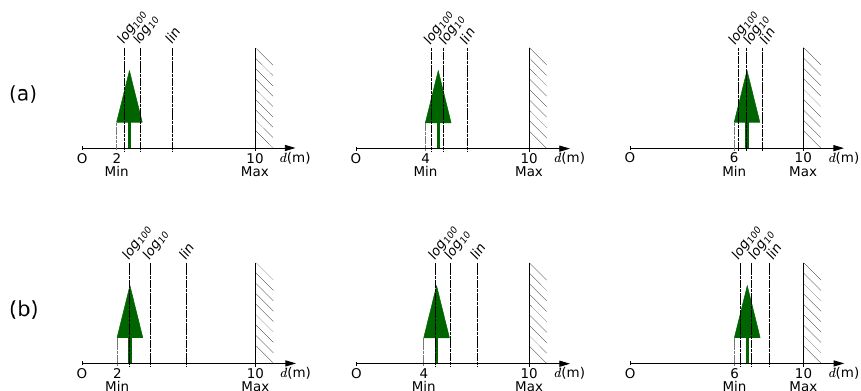
Figure 4. Examples of background removal for two logarithmic bases (10 and 100) of the proposed technique at different distances, compared to the linear form (lin). ( a ) Considering a cutoff factor of 0.4 and ( b ) considering a cutoff factor of